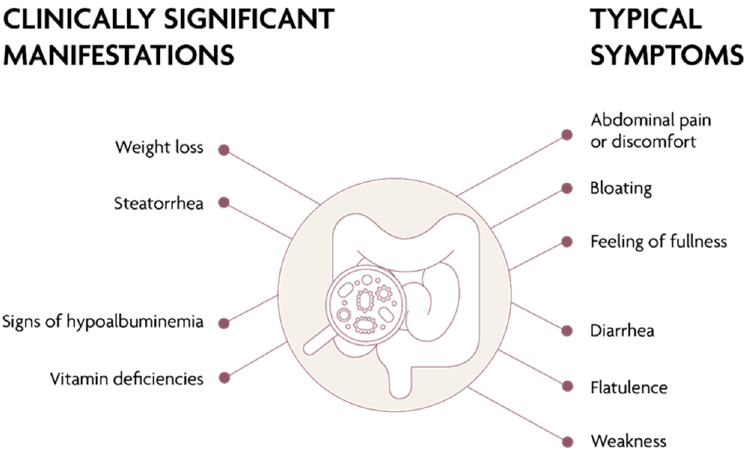
Figure 1. Clinical presentation of SIBO.